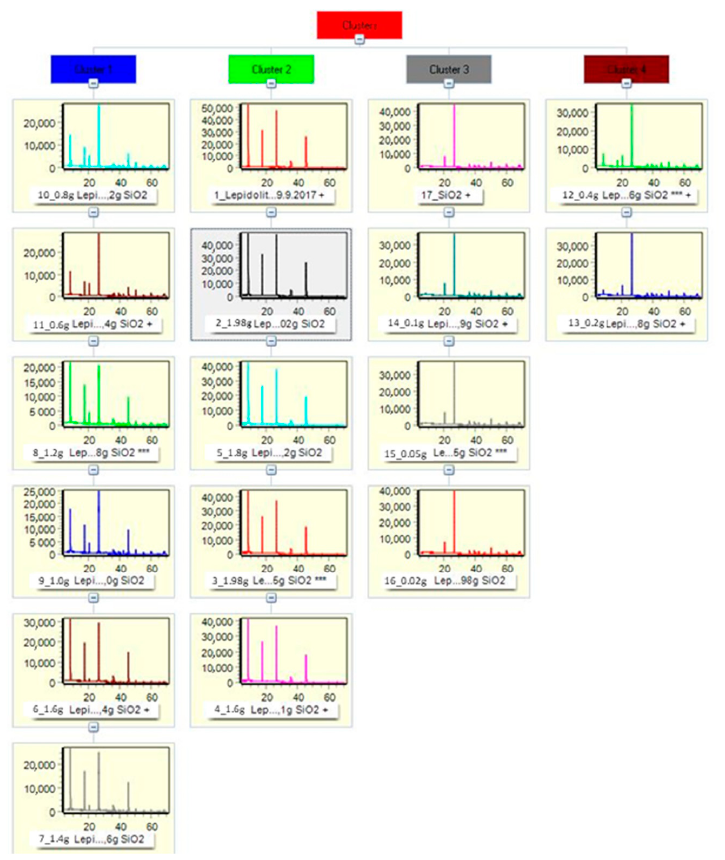
Figure 23. XRD patterns of quartz–lepidolite mixtures forming the relevant calculated clusters.